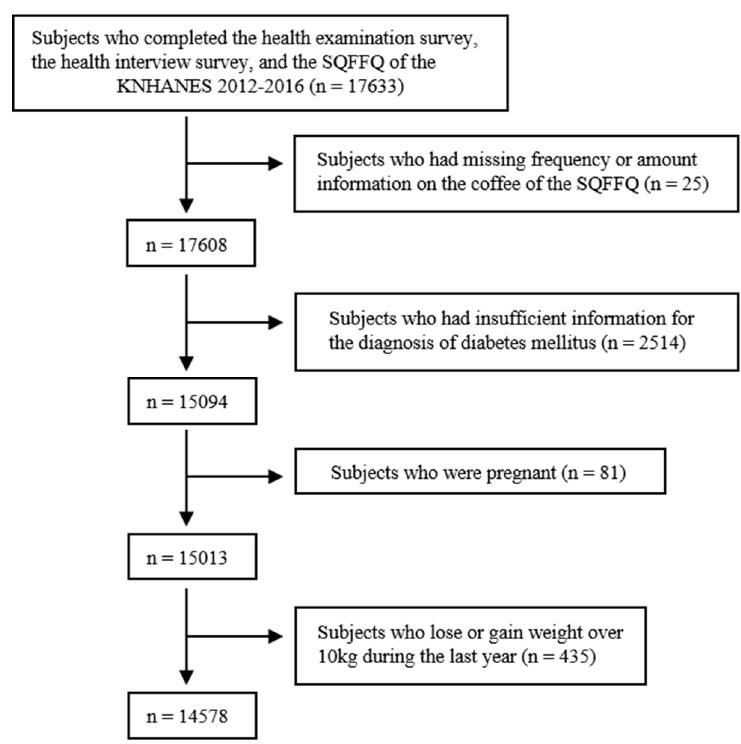
Figure 1. Flow diagram for the identification of the study population. A total of 14,578 subjects were finally included. KNHANES, Korea National Health and Nutrition Examination. SQFFQ, semi-quantitative food frequency questionnaires.